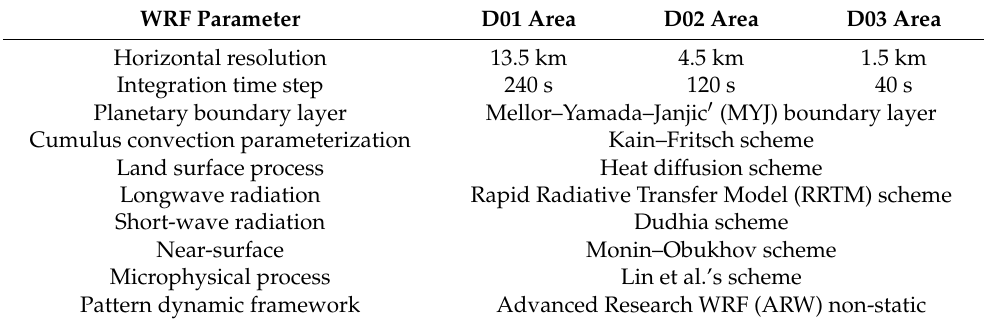
Table 1. Parameter settings of the WRF